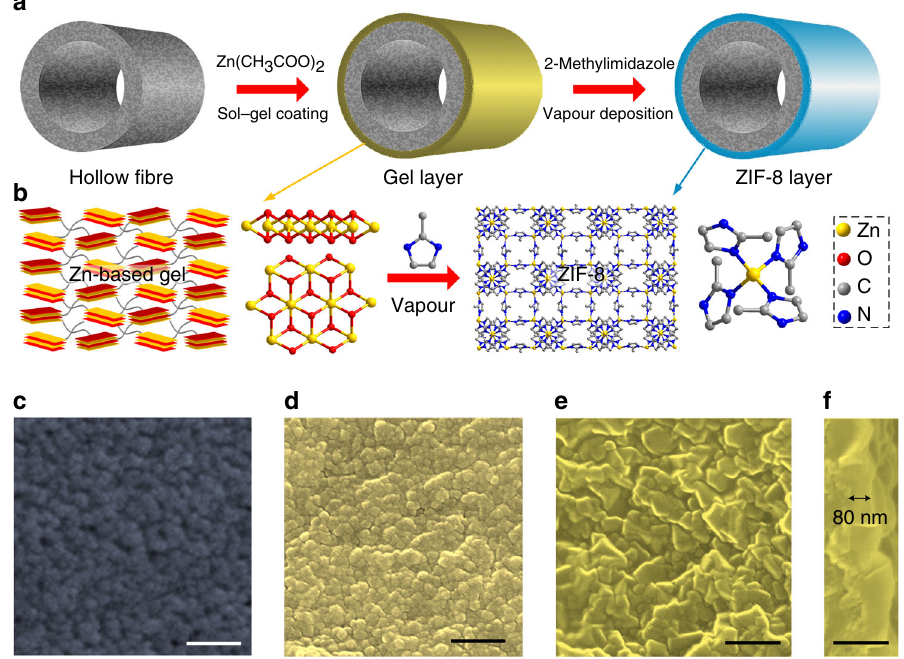
Fig. 1 GVD fabrication of ultrathin ZIF-8 membrane. a Schematic of MOF membrane formation process. b Schematic illustration and chemical structure of Zn-based gel and crystalline structure of ZIF-8. Zn, O, C and N atoms are depicted in yellow , red , grey and blue , respectively. H atoms are not presented for clarity. Top view SEM images of c the PVDF hollow fi bre and d the Zn-based gel layer. SEM images of e top and f cross-sectional view of the ZIF-8 membrane prepared with sol concentration of 1 U and coating time of 2 s. The images are coloured for clarity. Scale bar , 200